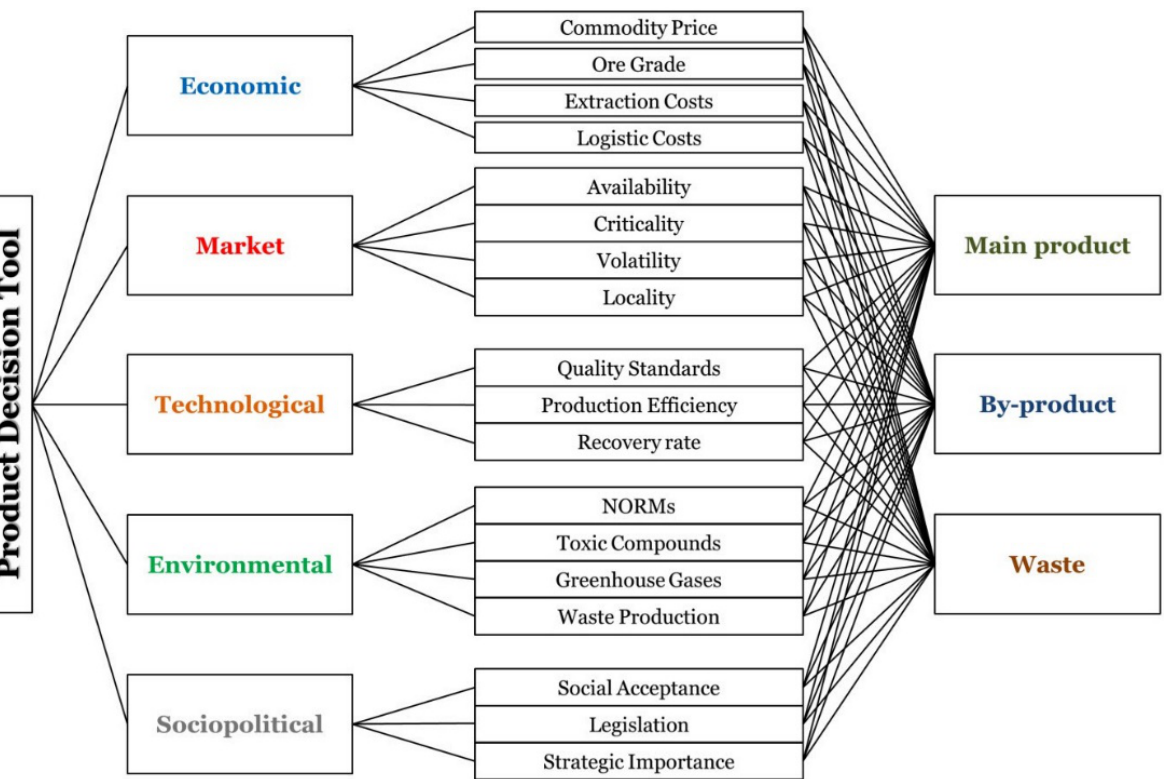
Figure 4. Hierarchy structure of the Product Decision Tool. Table 2. Category names and codes.